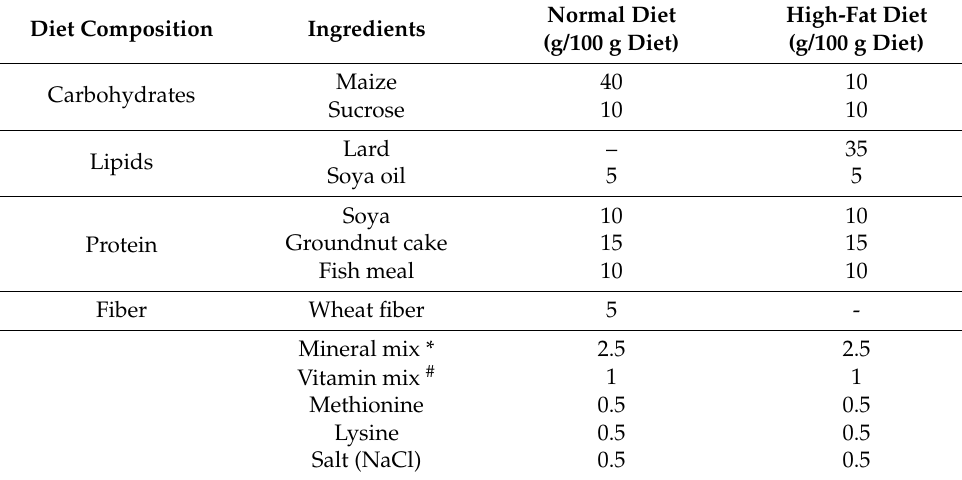
Normal Diet (g/100 g Diet)